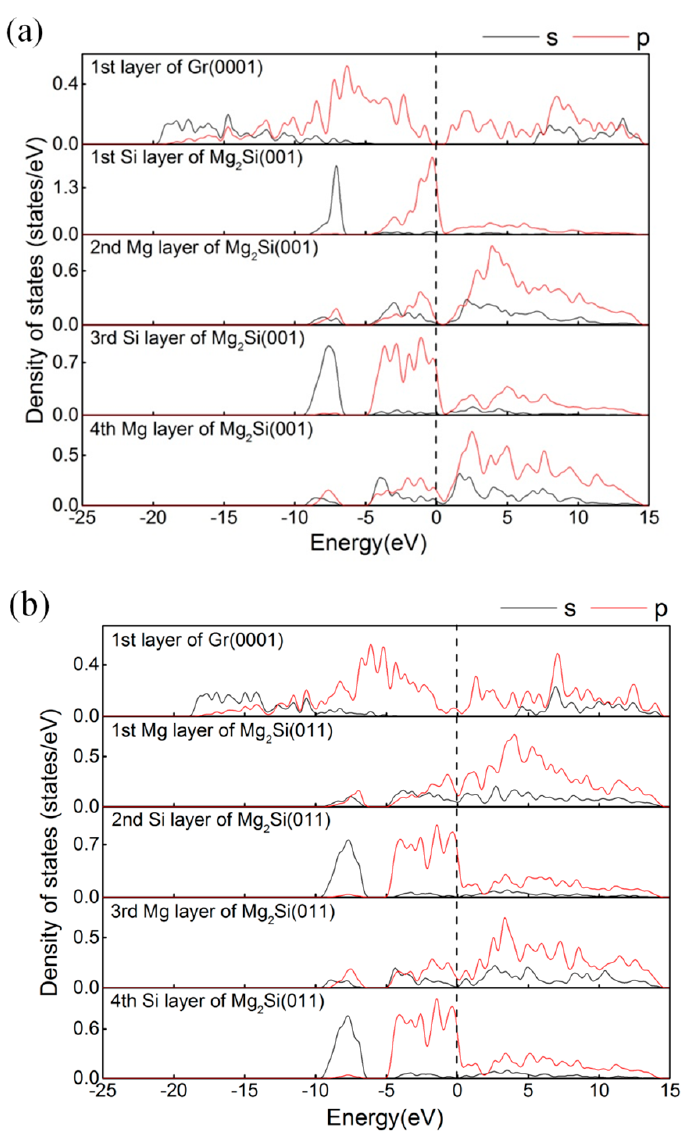
Figure 8. Partial density of states for Mg 2 Si (011)/Gr (0001) interfaces: ( a ) Si-center-sited; ( b ) Mg- center-sited.